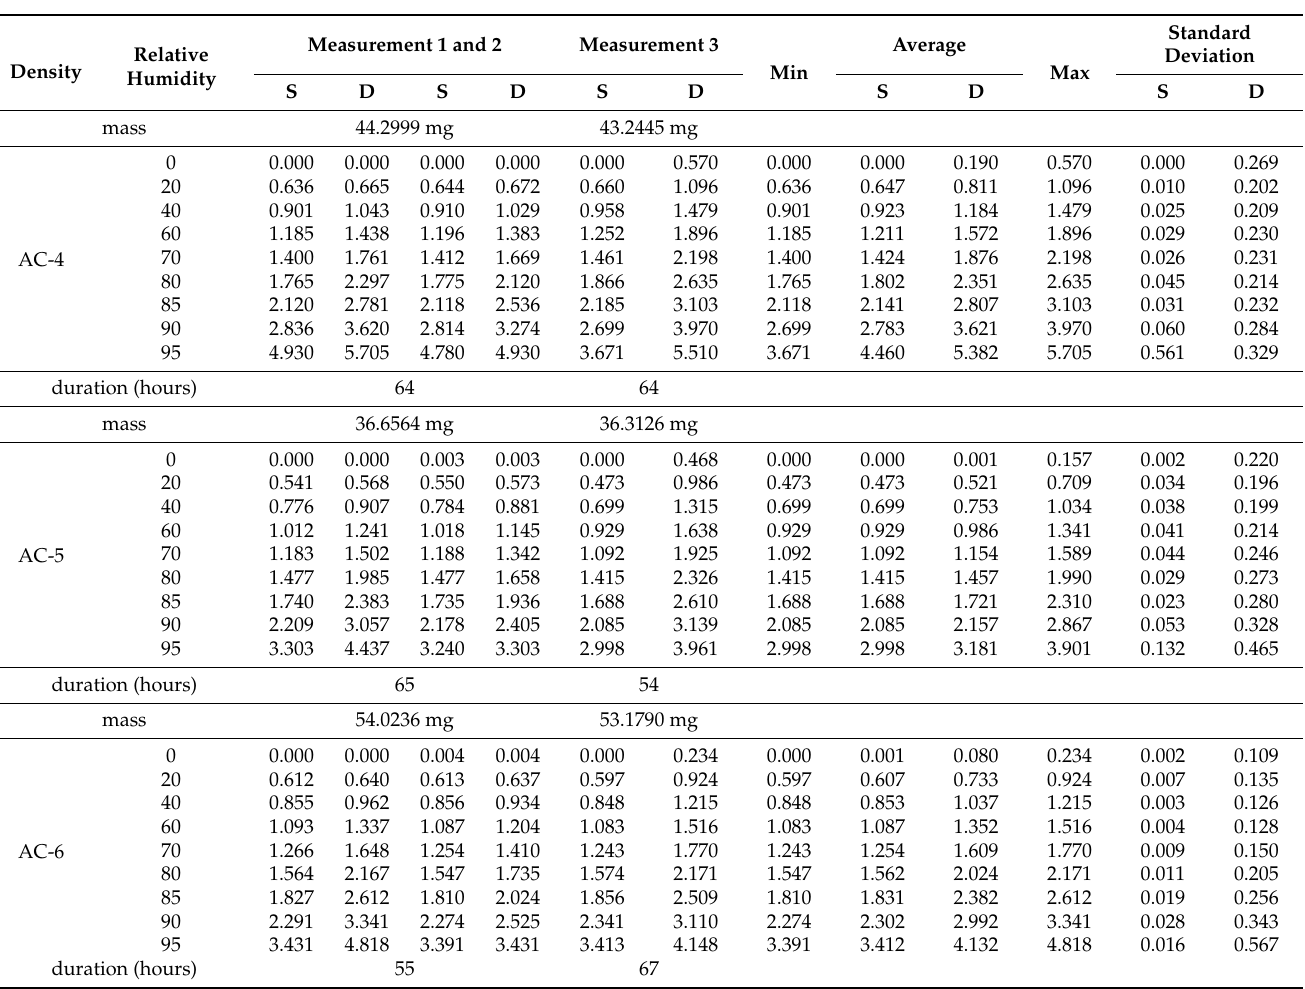
Table 9. Results of the dynamic vapor